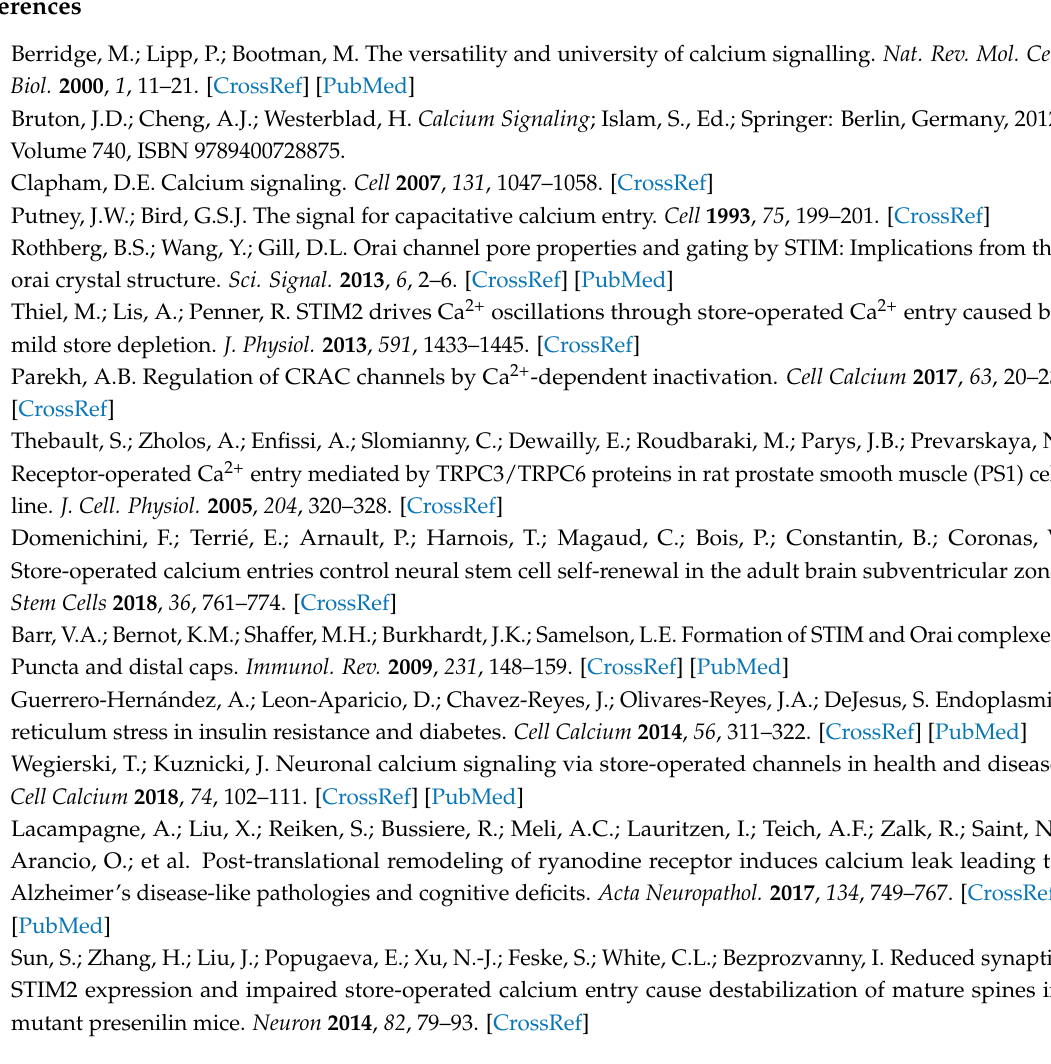
Table S1: Primer sequences, Table S2: Zebrafish Calcium Toolkit, Table S3: Zebrafish brain Calcium Toolkit, and Table S4: RNA Seq